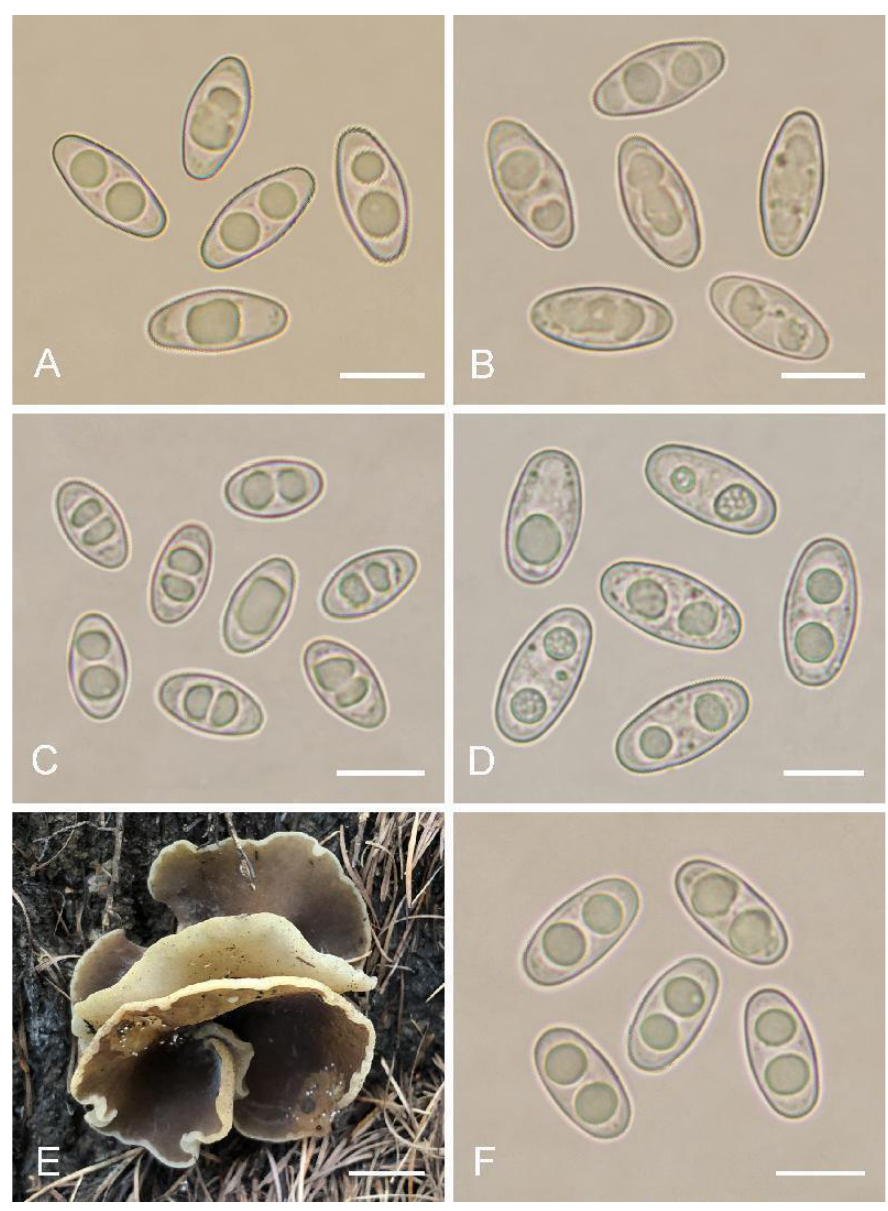
Figure 8. ( A – D , F ) ascospores, ( A ) Otidea purureogrisea WZ 2157 (HMAS 72805), ( B ) Otidea cf. purure- ogrisea (HMAS 23948), ( C ) Otidea sinensis (HMAS 268544), ( D ) Otidea sp. WZ 2123 (HMAS 72058), ( F ) Otidea aspera (HSA 251), and ( E ) apothecia (HSA 251). Scale bars: ( A – D , F ) = 10 μm , ( E ) = 1 cm.